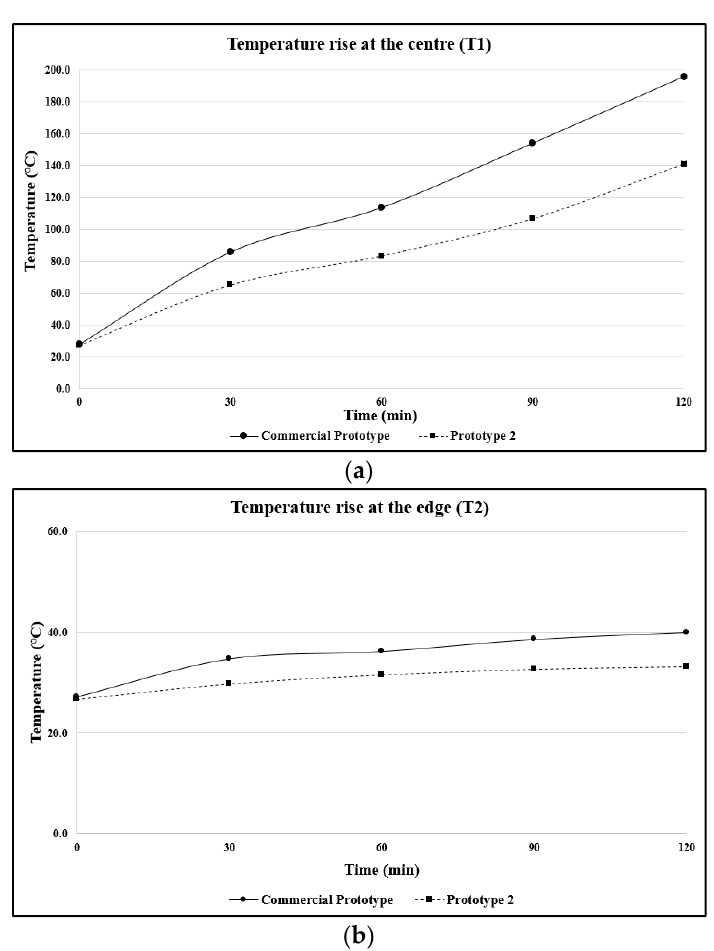
Figure 12. Temperature rise ratings at the center (T1) ( a ) and the edge (T2) ( b ) of the P2 and commercial prototypes.